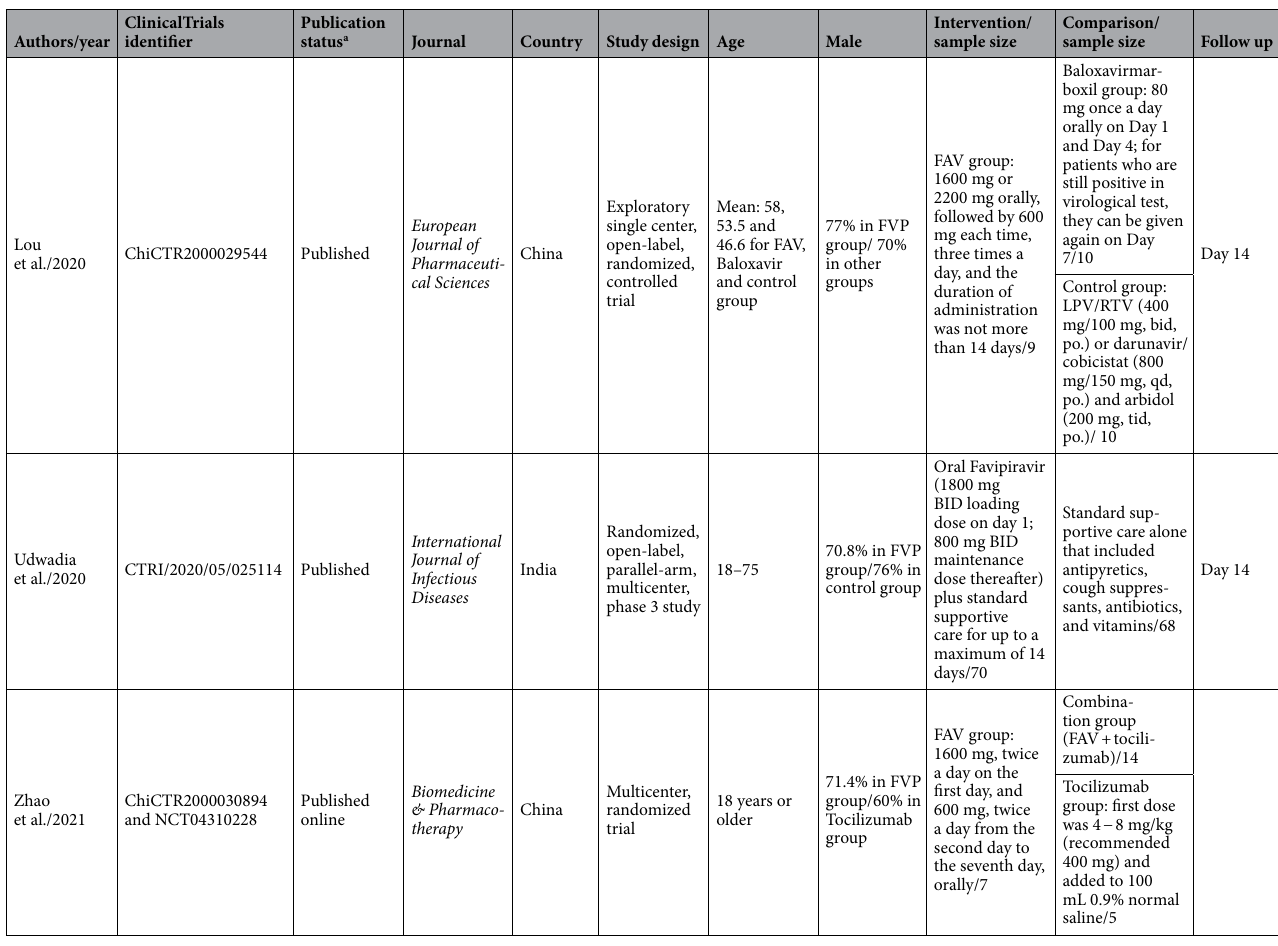
Table 1. summary characteristics of the included studies. NR not reported, FPV Favipiravir, LPV Lopinavir, RTV Ritonavir, HCQ hydroxychloroquine. a The status of manuscript in time of